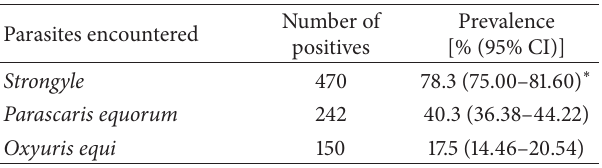
Table 2: Prevalence of gastrointestinal nematode parasite of don- keys ( Equus asinus ) in northeastern Nigeria ( 𝑛 = 600 ).